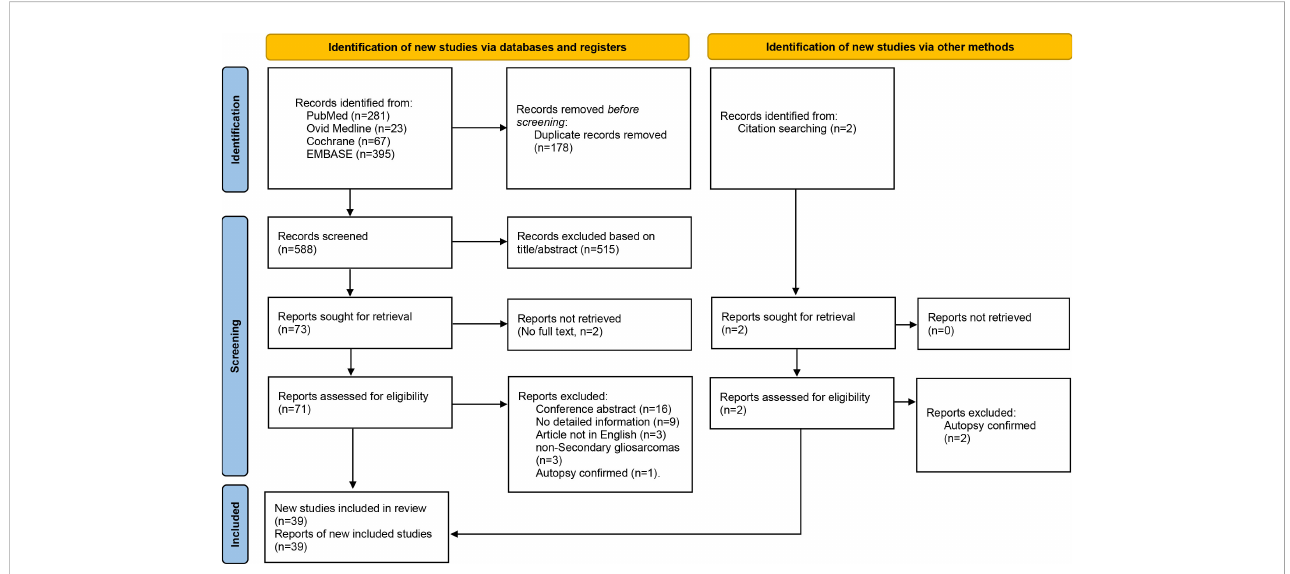
FIGURE 1 PRISMA fl ow diagram showing the inclusion and exclusion process for the